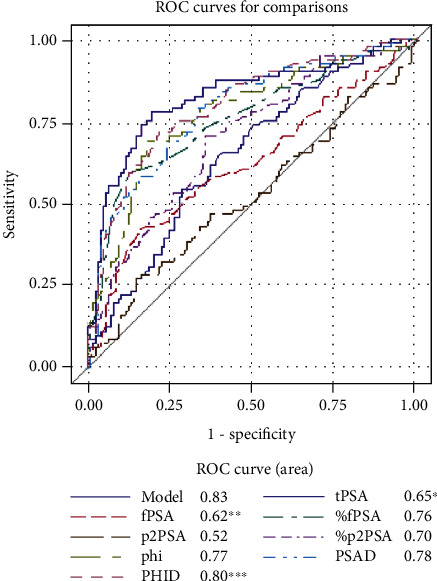
Receiver operating characteristic curves representing the diagnostic ability of blood serum biomarkers in predicting clinically significant prostate cancer according to Epstein's criteria. Abbreviations: ISUP: International Society of Urological Pathology; fPSA: free prostate-specific antigen; %fPSA: free to total PSA ratio; phi: Prostate Health Index; PHID: phi density; PSAD: PSA density; ROC: receiver operating characteristic; tPSA: total PSA; %p2PSA: p2PSA to fPSA ratio. All significant differences are marked with asterisk (∗), (∗∗), and (∗∗∗): ∗P < 0.05 for tPSA vs. %fPSA, p2PSA, phi, PSAD, and PHID. ∗∗P < 0.05 for fPSA vs. %fPSA, phi, PSAD, and PHID. ∗∗∗P < 0.05 for PHID vs. p2PSA and %p2PSA.